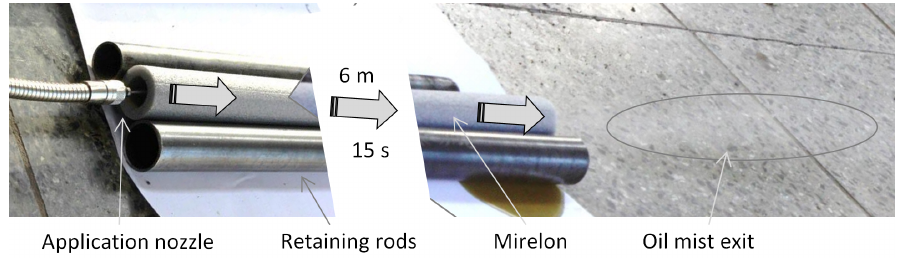
Figure 2. Method of application of oil mist during the experiment.